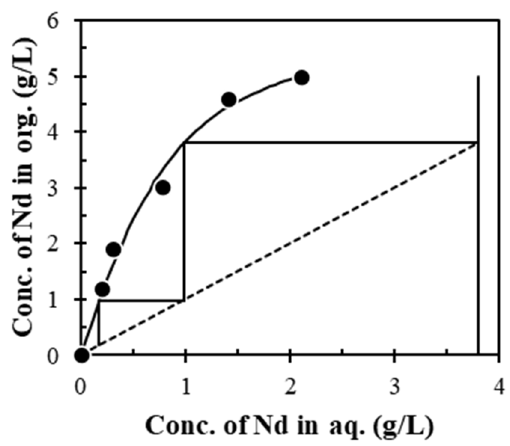
Figure 9. McCabe–Thiele plot for extraction of Nd from leach liquor [Leach liquor: 3.9 g/L Nd; ex- tractant: 10% PC88A diluted in kerosene; time: 10 min; O/A ratio: 1/1].